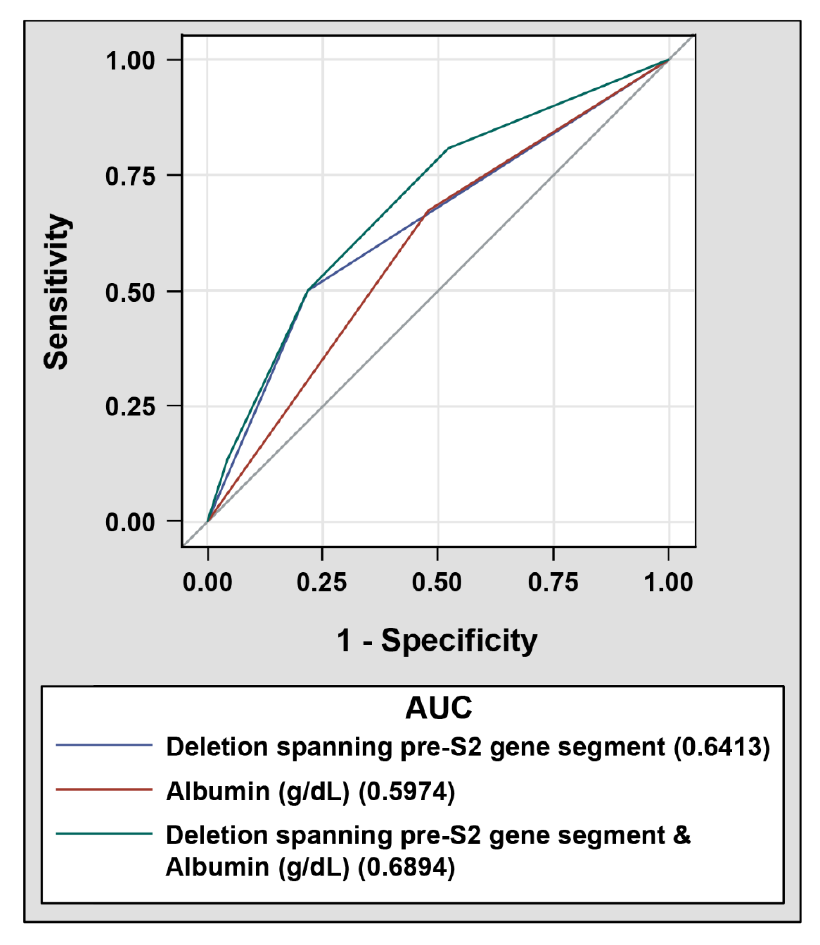
Figure 2. ROC curves of selected prognostic factors in discriminating patients with HCC recurrence from those without after curative surgical resection; 52 patients with and 23 patients without HCC recurrence were analyzed. (bottom) AUC for the deletion spanning the pre-S2 gene segment (solid blue line), serum albumin level (solid red line), or the combination of both factors (solid green line).